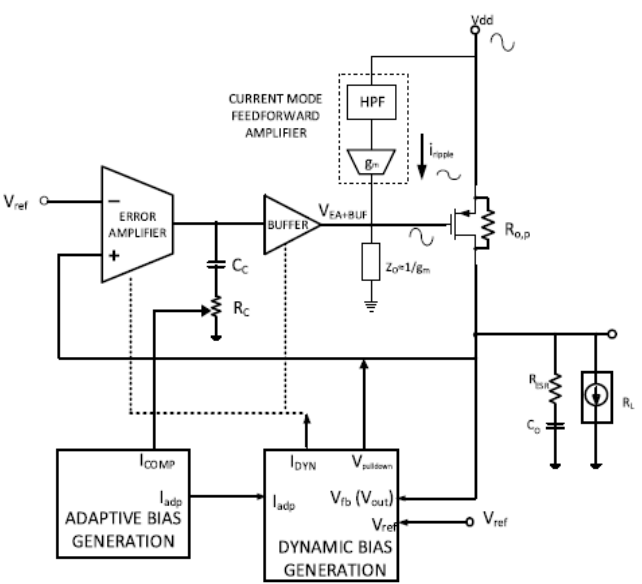
Figure 18. Current-mode FFRC-based ALDO [46].